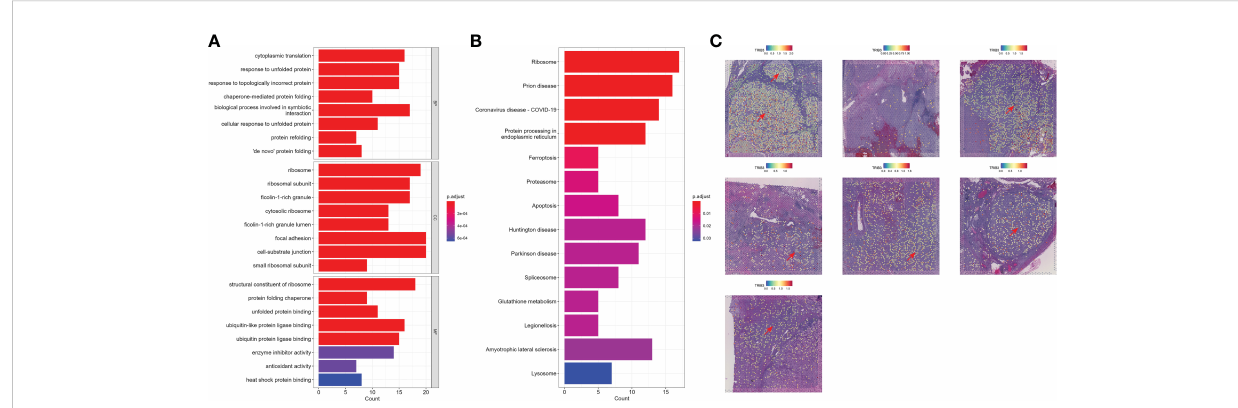
FIGURE 7 Functional analysis and spatial localization of TRIB3 high tumor cells. (A) Gene Ontology enrichment analysis for upregulated differentially expressed genes (DEGs) in TRIB3 high tumor cells. (B) Kyoto Encyclopedia of Genes and Genomes pathway analysis for upregulated DEGs in TRIB3 high tumor cells. (C) Visualization of TRIB3 high tumor cells in kidney renal clear cell carcinoma spatial transcriptome tissue sections.